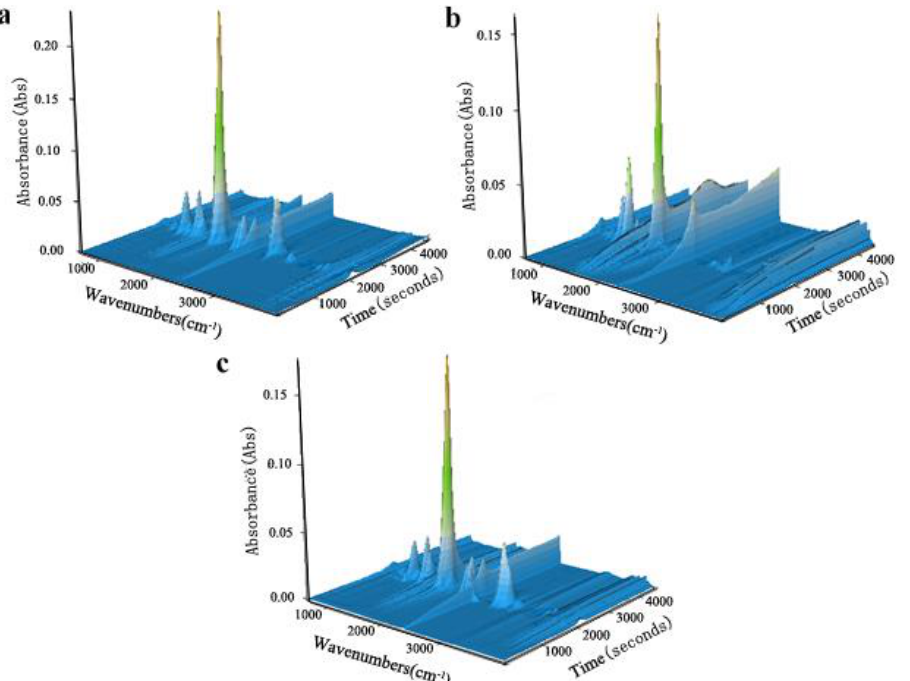
Figure 4. Three-dimensional thermogravimetry-Fourier transform infrared spectrometry (TG-FTIR) spectra of gaseous products in the thermal decomposition of PLA and flame-retardant composites: ( a ) PLA, ( b ) BC/PLA, and ( c ) BC/PLA/AHP.